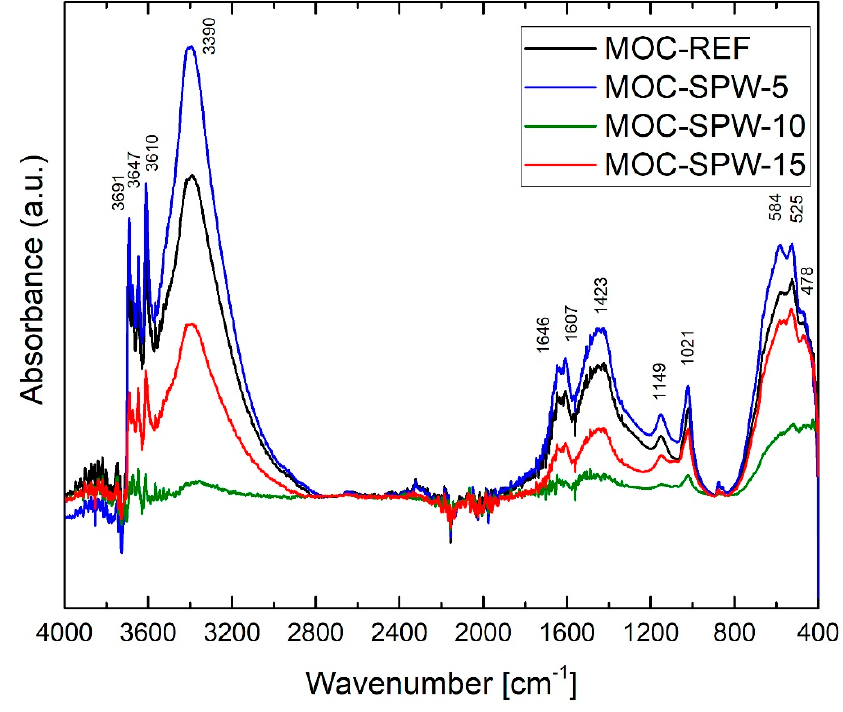
Figure 4. IR spectra of MOC-REF, MOC-SPW5, MOC-SPW10, and MOC-SPW15.